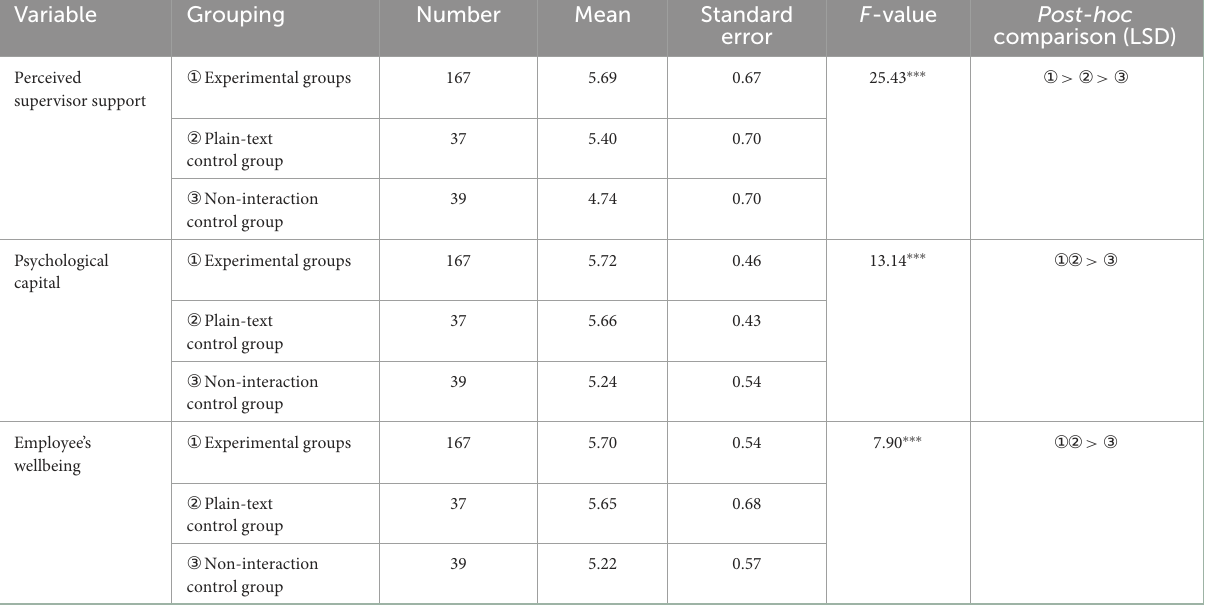
TABLE 3 ANOVA analysis of experimental